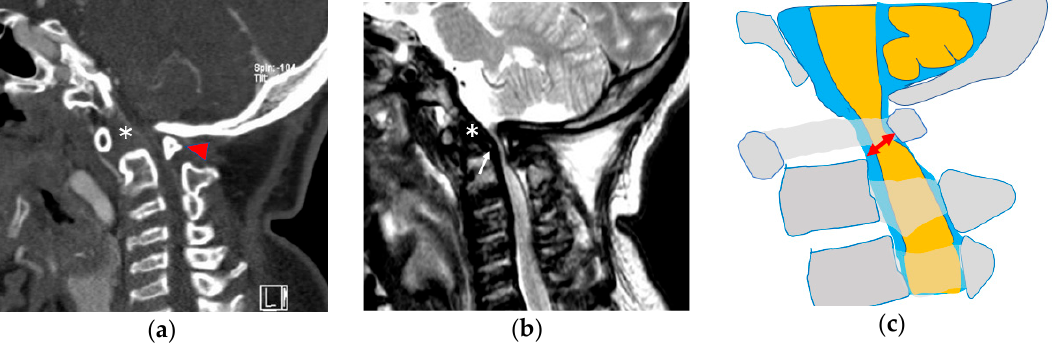
Figure 2. Atlantoaxial instability in MPS IVa. Hypoplasia of the dens (asterisk) and C1 posterior arch (arrowhead) are more clearly recognized in computed tomography ( a ), while GAG accumulation (white arrow) and spinal cord compression are more identifiable in magnetic resonance images ( b ). The space available for the cord (red arrow) indicates the most narrowing between the posterior wall of C2 and the C1 posterior arch ( c ). This patient had tetraplegia and required ventilator control because of irreversible spinal cord damage at the craniocervical junction.